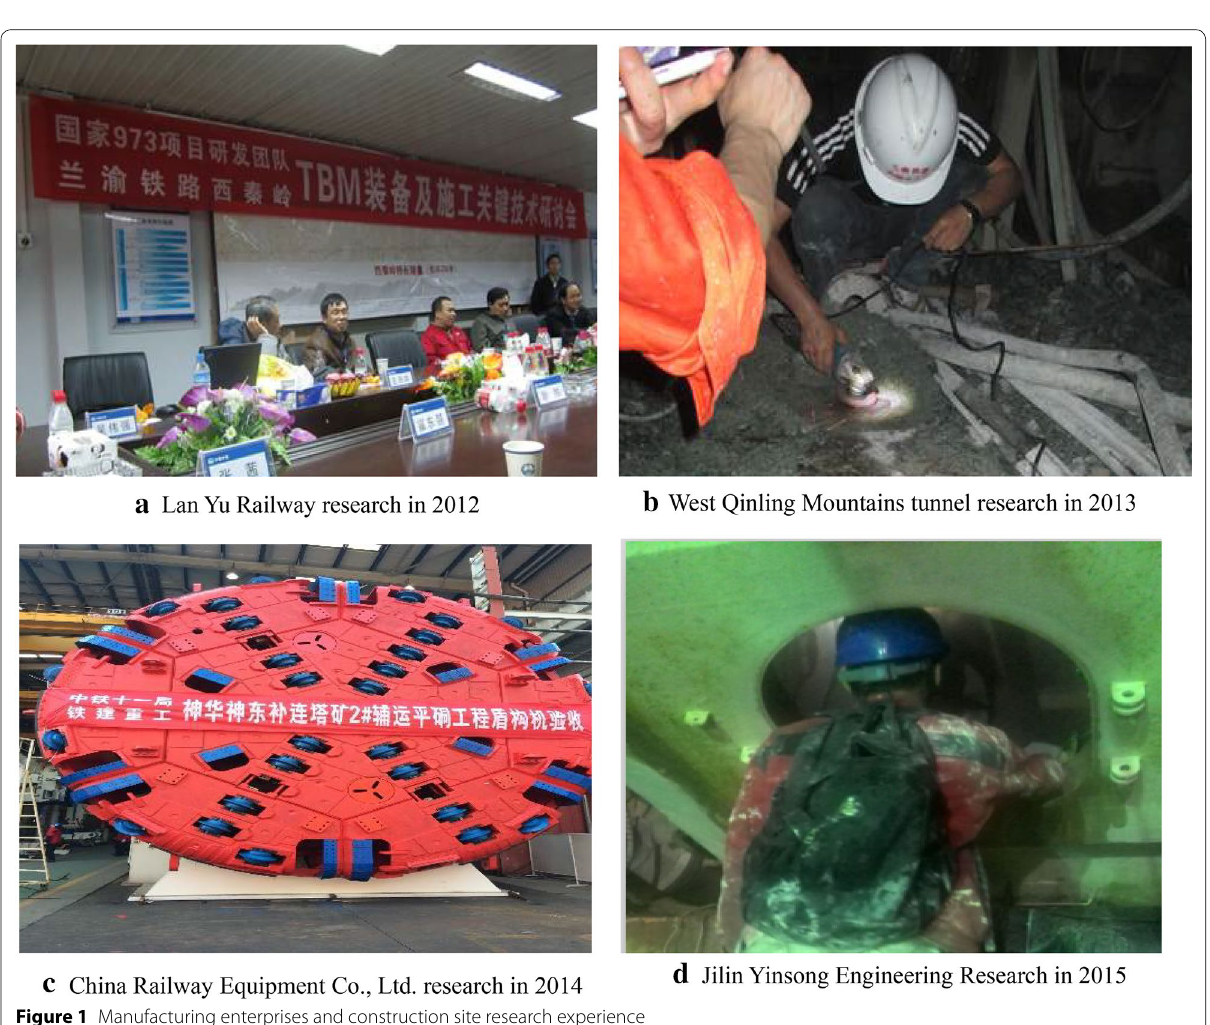
Figure 1 Manufacturing enterprises and construction site research experience